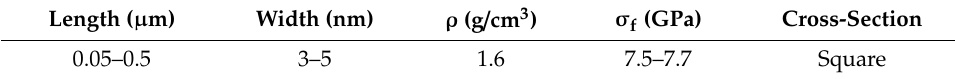
Table 1. Physical and chemical properties of cellulose nanocrystals (CNCs).